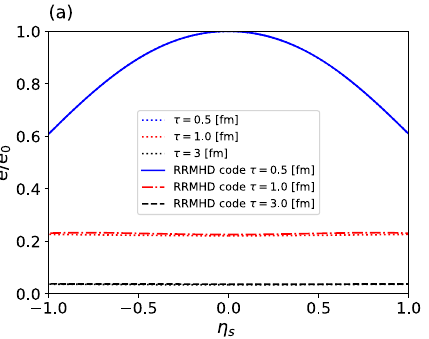
The blue, red, and black dotted lines show the semi-analytic solutions of the a Eqs. (A.17), (A.18), and b Eq. (81) divided by Eq. (80) at t = 0 . 5 , 1 . 0 and 3 . 0 fm,